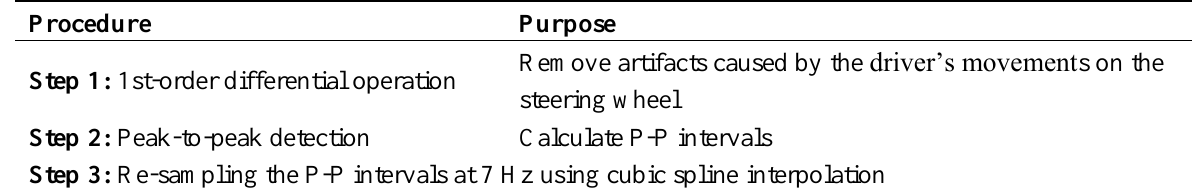
Table 2. HRV extraction from PPG raw data in